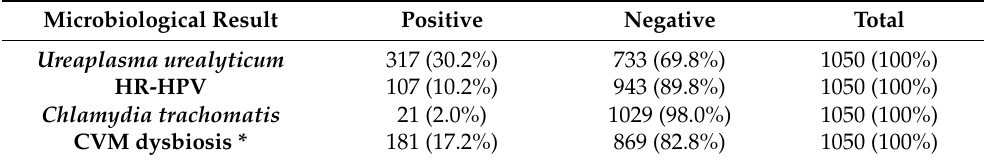
Table 2. Distribution of women with regard to microbiological results ( N = 1050).